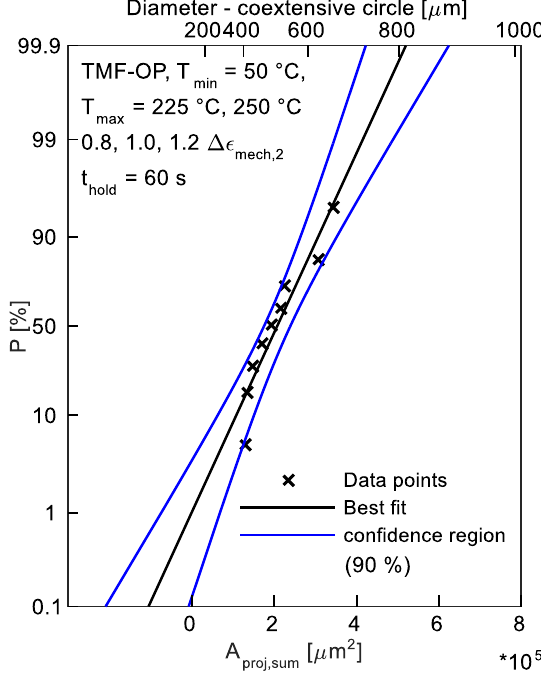
Figure 12. Sum of A proj of discontiguous single pores at crack origins detected by SEM and µ CT in probability plot of logit distribution for all available specimens.